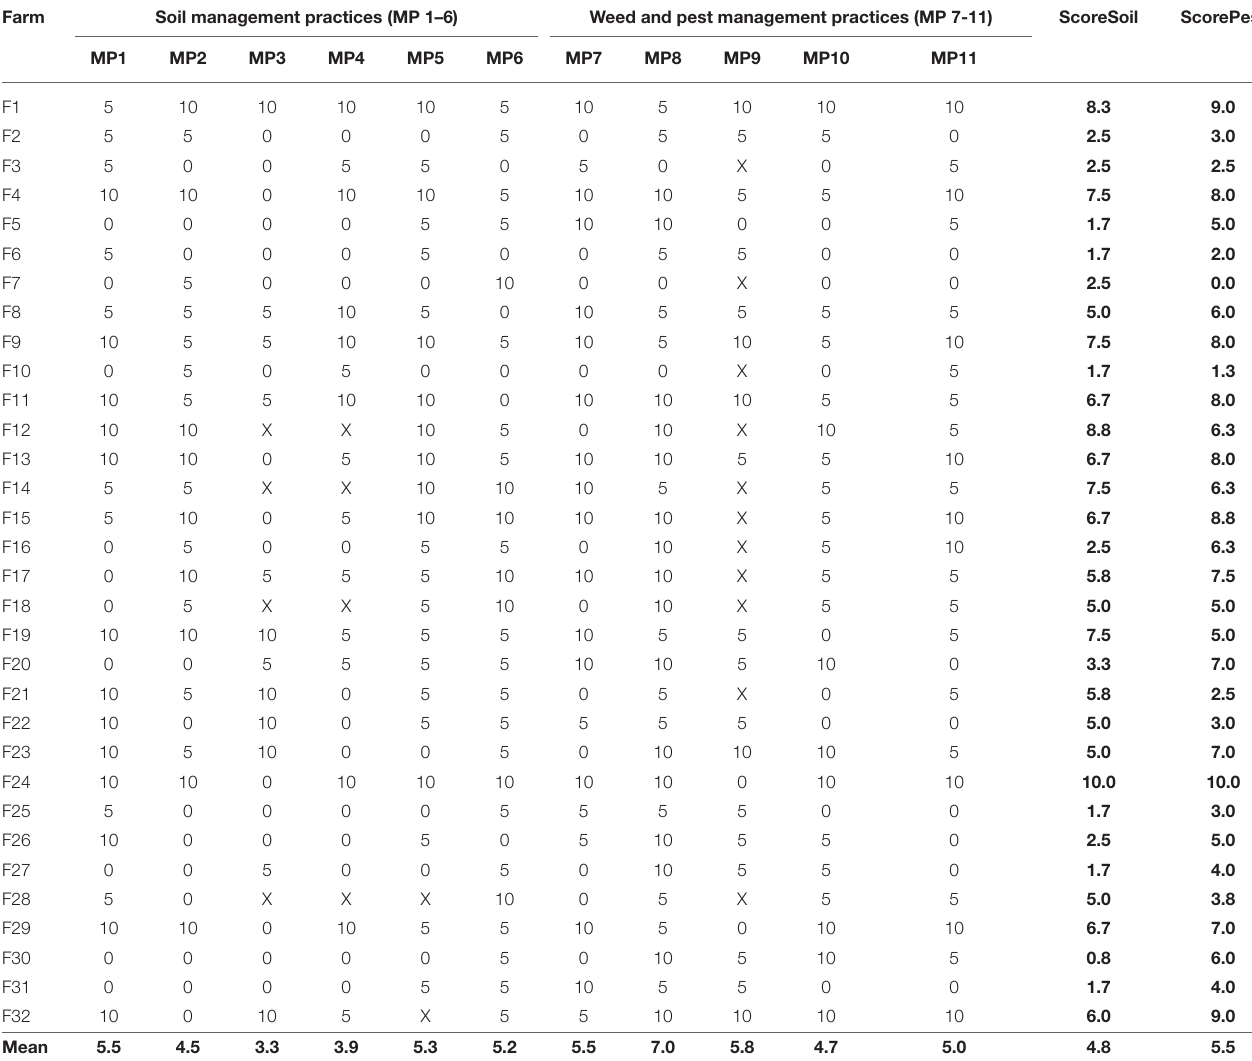
TABLE 4 | Grading of the 11 management practices (MP) for the 32 farms.